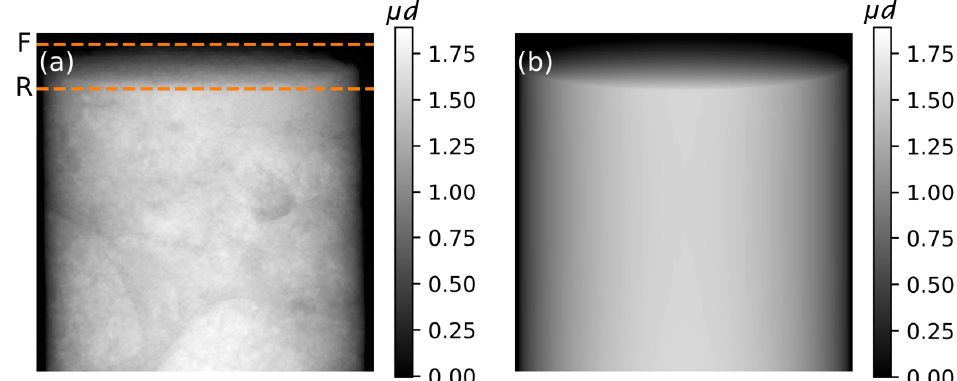
Figure 3. ( a ) Projection of the concrete rod. The detector rows on which the front (F) and rear (R) edge of the concrete rod are respectively projected are marked by horizontal lines. ( b ) Simulated projection of a homogeneous cylinder of dimensions equal to the rod. The greyscale values in both figures correspond to the attenuation integral values μ d .